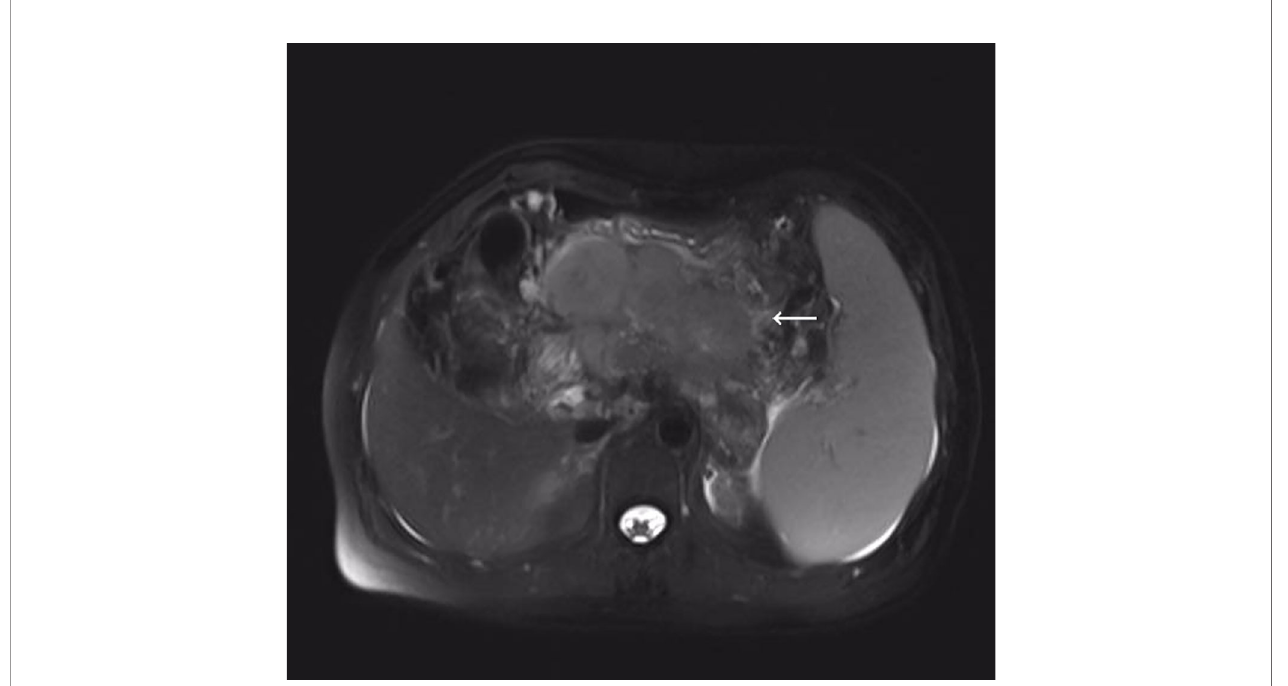
FIGURE 1 | T2-weighted magnetic resonance imaging (MRI) showed irregular pancreatic mass measuring 105 mm in the maximum